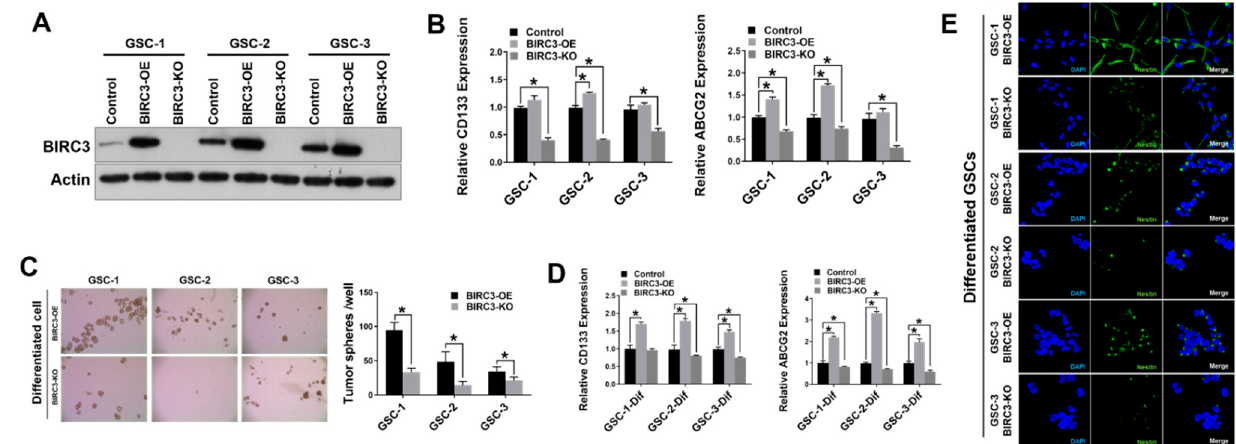
Figure 2. Human GBM stem cell self-renewal is regulated by BIRC3 expression. ( A ). Protein expres- sion of BIRC3 in three different GSCs. Each GSC includes control, BIRC3-OE and BIRC3-KO groups. Specific antibodies as indicated. β -actin acts as internal control. ( B ). CD133 and ABCG2 mRNA expression analyzed by real time PCR in control, BIRC3-OE and BIRC3-KO GSCs. n = 3, * p < 0.05. ( C ). Control, BIRC3-OE or BIRC3-KO of differentiated GSCs were seeded in 6-well plate and cultured in neurosphere formation medium. The number of neurospheres were observed and calculated by microscope. Representative images are under 4 × magnification. n = 5, * p < 0.05. ( D ). CD133 and ABCG2 mRNA expression analyzed by real time PCR in control, BIRC3-OE and BIRC3-KO of differentiated GSCs. n = 3, * p < 0.05. ( E ). Immunofluorescence staining of Nestin in differentiated BIRC3-OE and BIRC3-KO